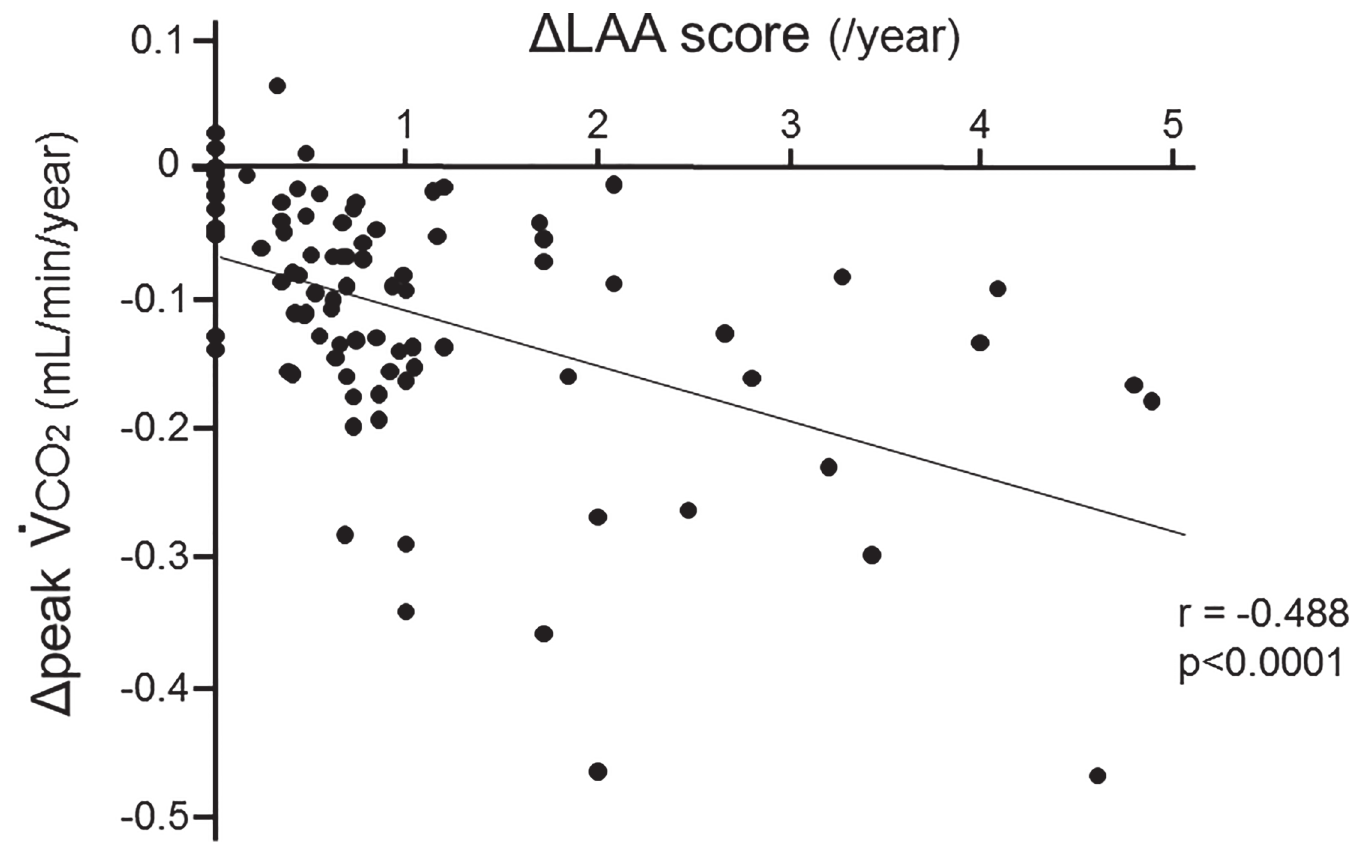
Fig 6. Association between the decline in CO2 production and development of emphysema. There was a significant correlation between the mean annual changes in peak _ V CO 2 ( Δ p _ V CO 2 ) and those in the total LAA scores ( Δ LAA) (p < 0.0001, r =